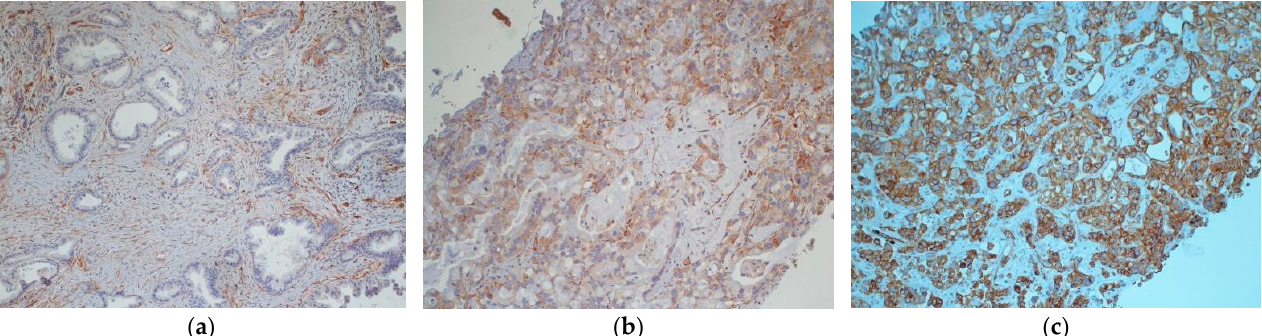
Figure 1. Examples of tumoral Caveolin ‐ 1 expression ( a ) Caveolin ‐ 1 negative sample (0) ( b ) Caveolin ‐ 1 positive sample (2+) ( c ) Caveolin ‐ 1 positive sample (3+).